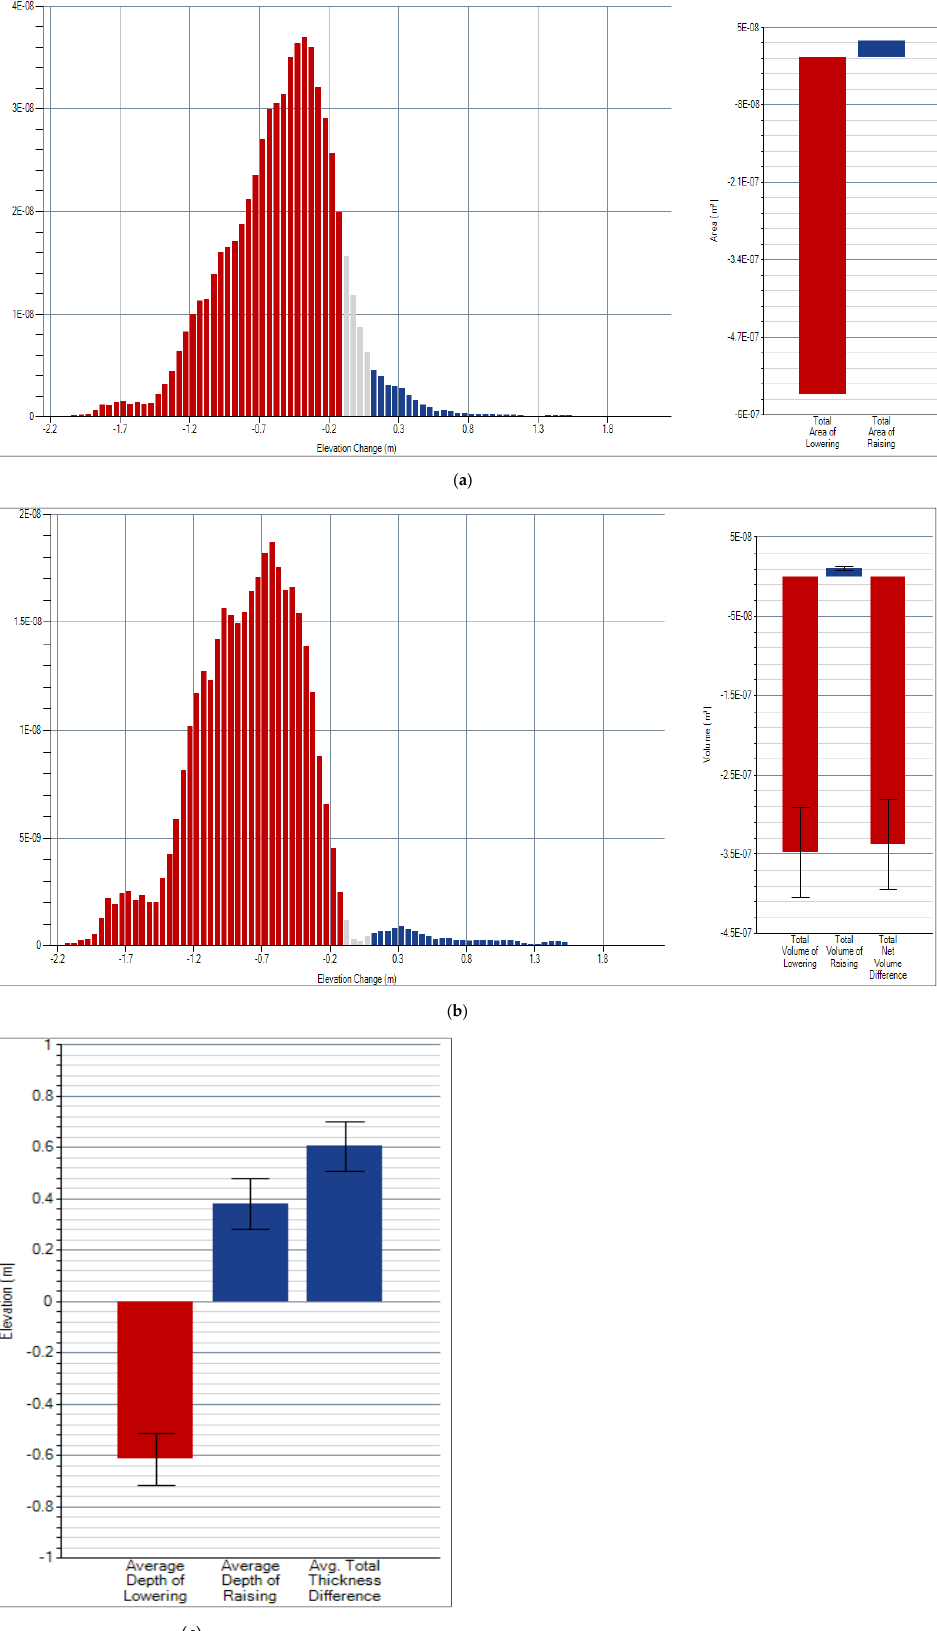
Figure A1. GCD result for ROI2.